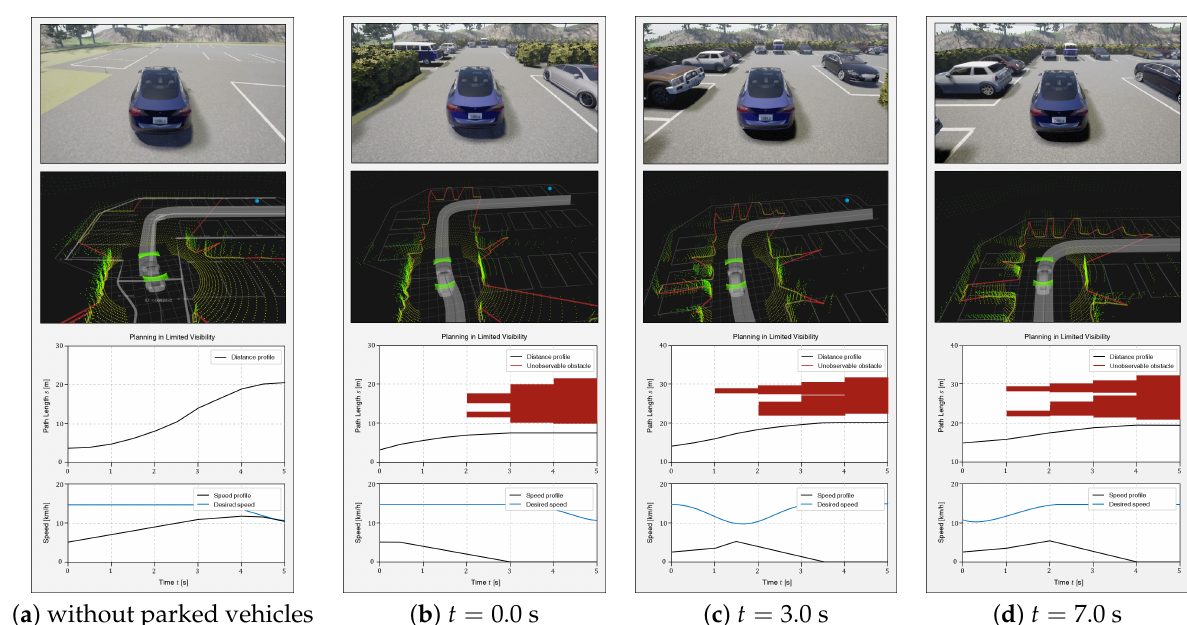
Figure 10. Roaming in a parking lot without obstacles. The upper figure of each time step shows the situation in CARLA. The second figure describes the algorithm in ROS platform. The last figure shows the speed profile at each time